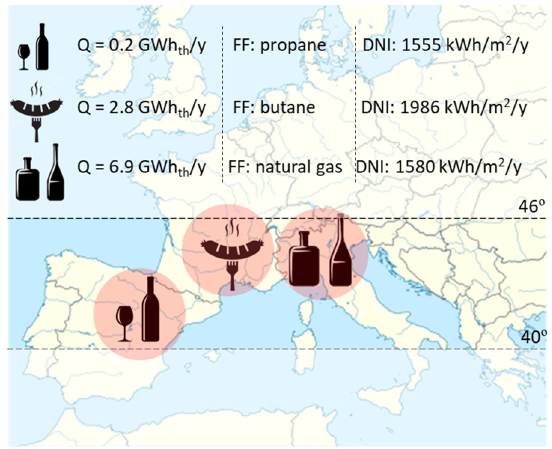
Figure 1. Location, agri-food sector, yearly heating demand, currently employed heating source and direct normal irradiance (DNI) for the three demo cases analysed in this study: Spanish winery, Italian spirits distillery and French charcuterie.